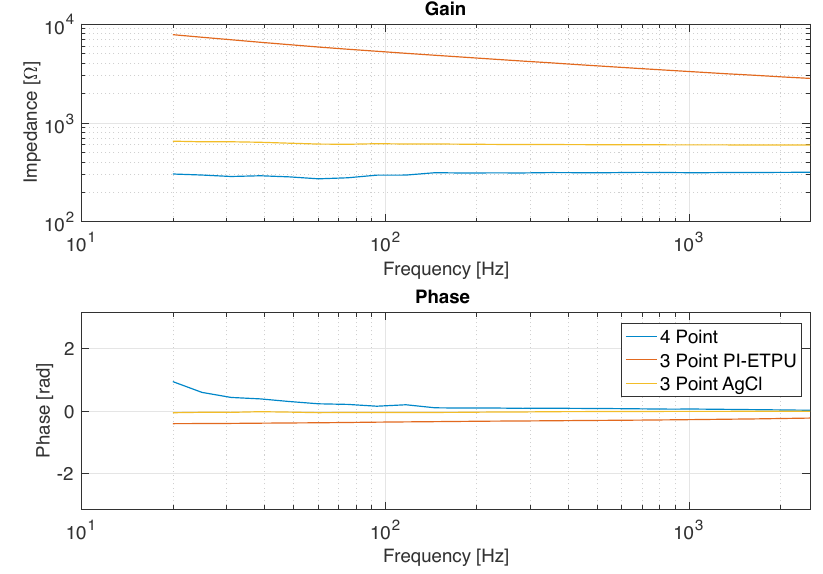
Figure 9. Impedance of the ETPU and AgCl electrodes in contact with 0.9% NaCl solution (3-point) and 0.9% NaCl solution